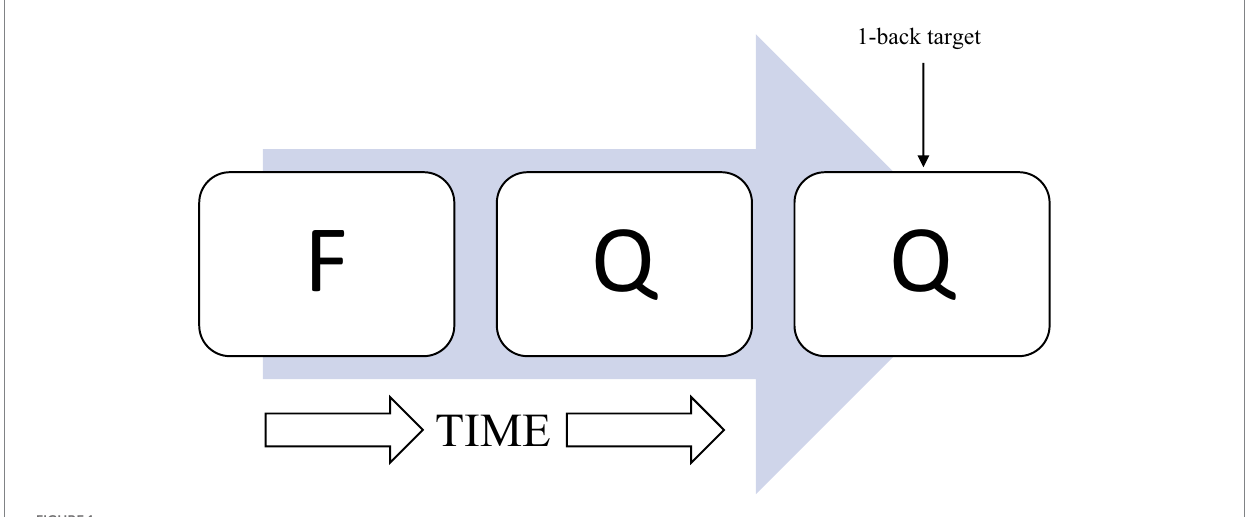
FIGURE 1 Illustration of 1-back task. A series of consonants is presented onto a computer monitor one at a time. One consonant was presented every 2 s. Participants indicated whether the letter presented was the same or different as the letter N-back, where “N” represented the specific number of letters